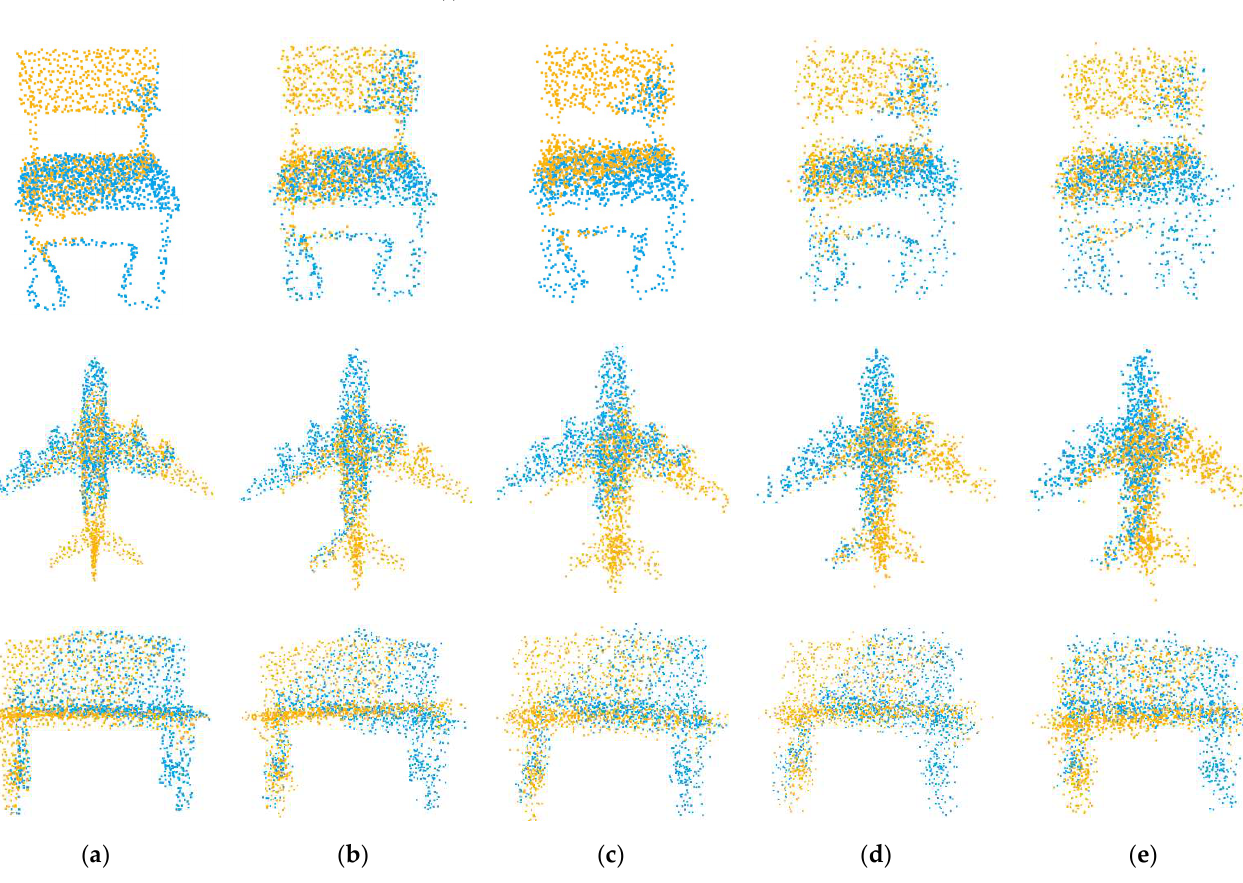
Figure 7. Errors of learning-based methods with different noise levels. ( a ) The experimental results of compared methods in terms of RMSE(R); ( b ) The experimental results of compared methods in terms of RMSE(t).